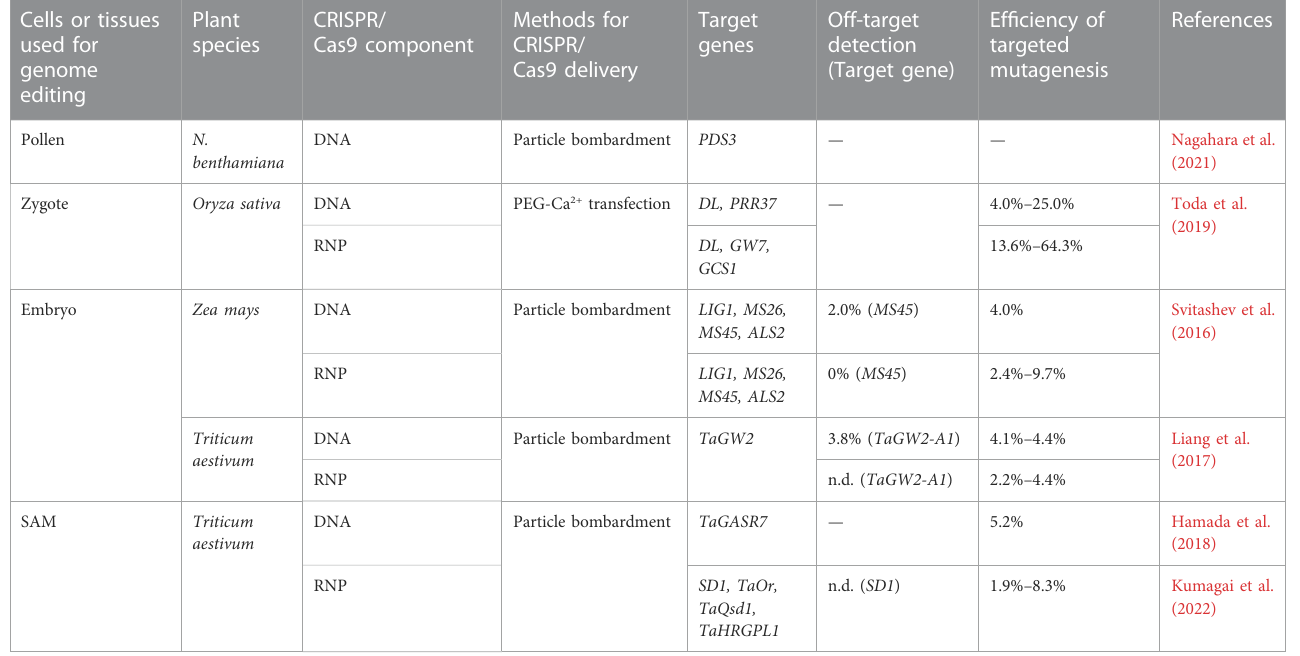
TABLE 1 Genome editing by direct delivery of CRISPR/Cas9 components into plant reproductive cells or tissues. Cells or tissues used for genome